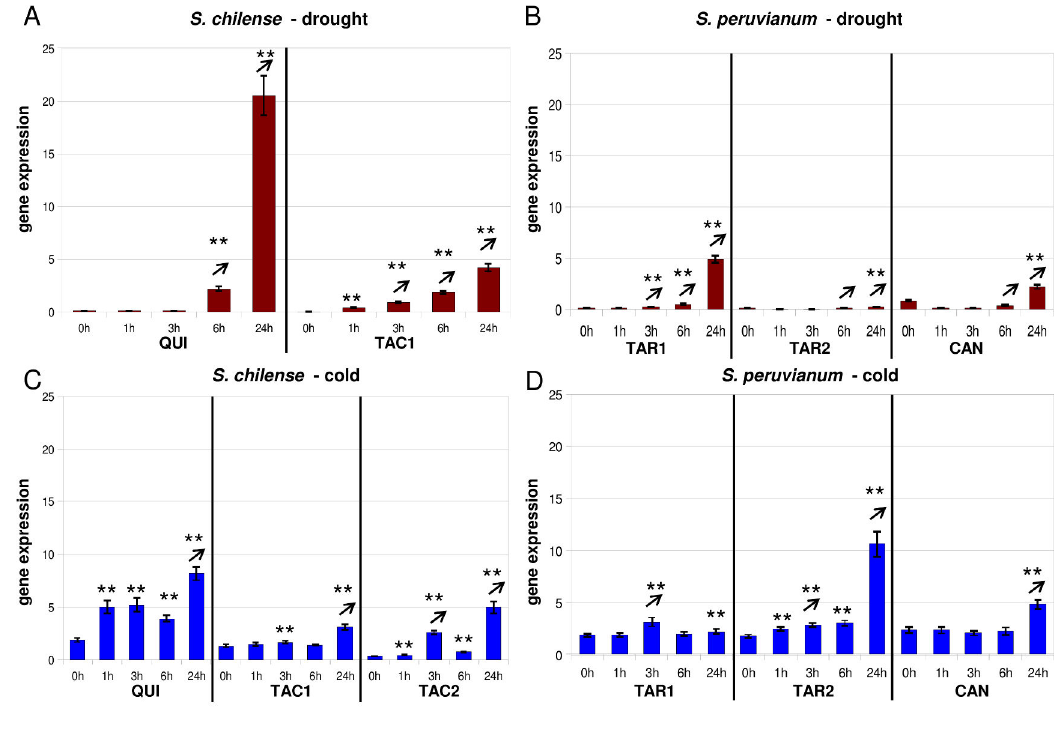
Figure 2. Gene expression of Asr2 after application of drought and cold stress. (for explanation see Figure 1). doi: